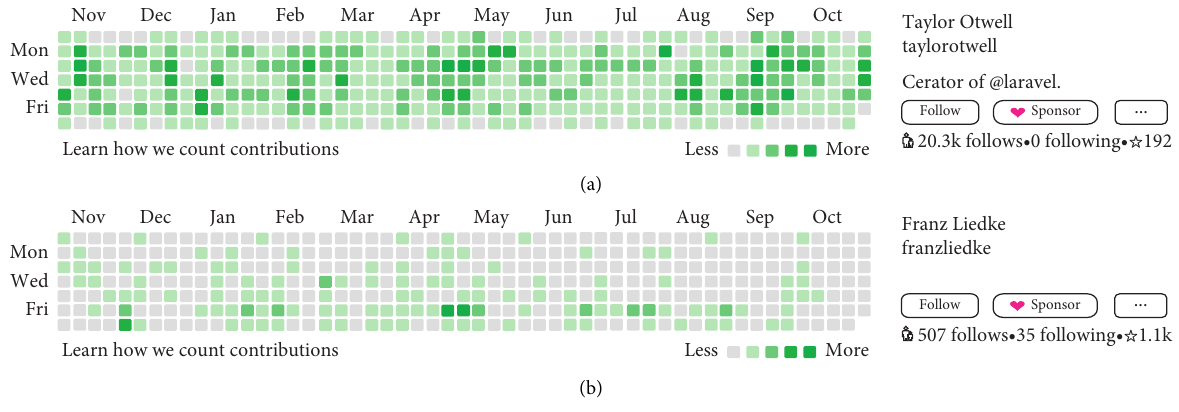
Figure 1: A comparison of two developer Table 1: Notations and explanations.